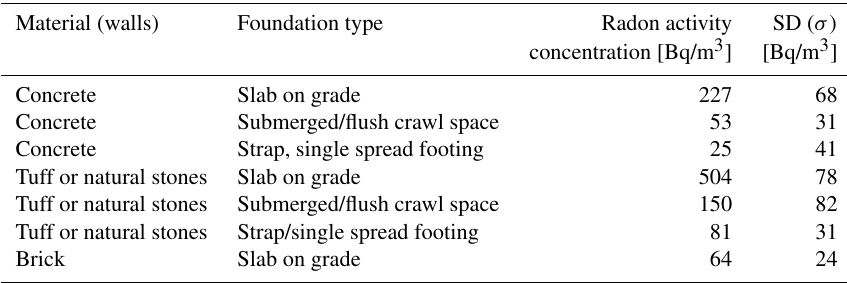
Table 6. Mean value of radon activity concentrations in indoor air at the basement ground floor grouped according the material of the wall and the foundation